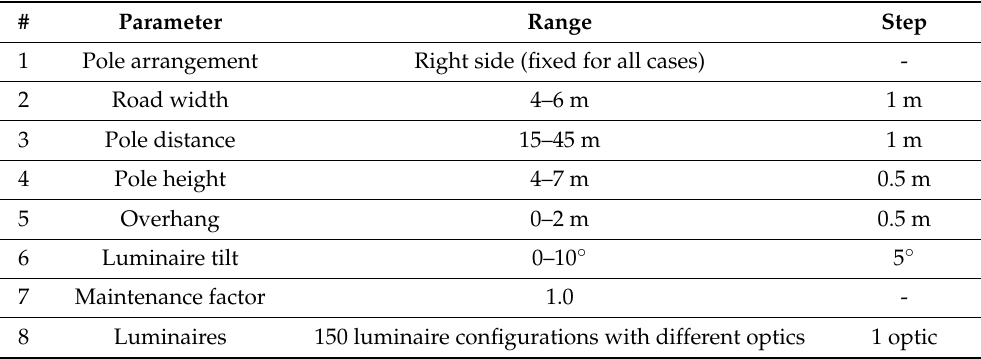
Table 1. Road lighting calculation parameters used in